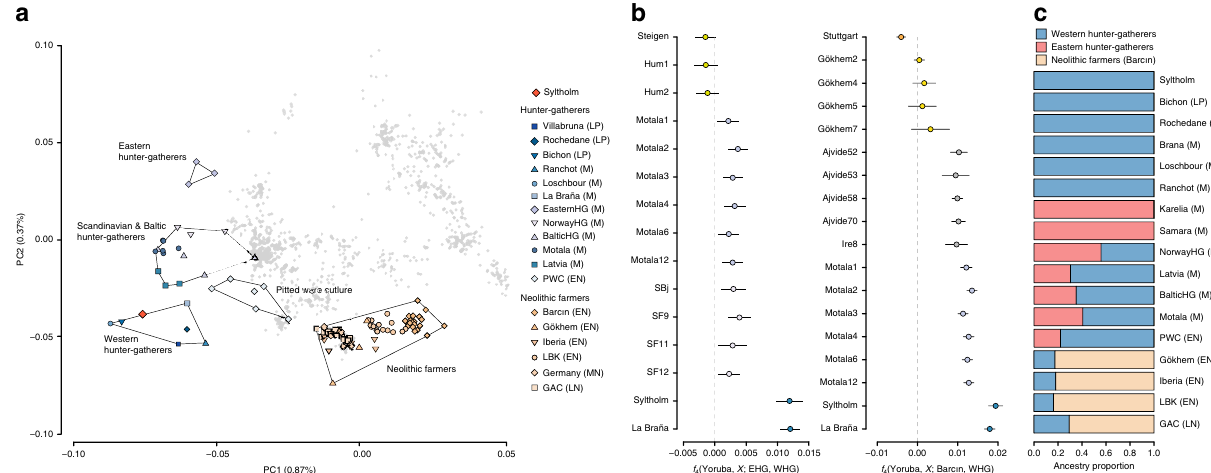
Fig. 2 Genetic af fi nities of the Syltholm individual. a Principal component analysis of modern Eurasian individuals (in grey) and a selection of over 100 previously published ancient genomes, including the Syltholm genome. The ancient individuals were projected on the modern variation (see Methods). b Allele-sharing estimates between the Syltholm individual, other Mesolithic and Neolithic individuals, and WHGs versus EHGs and Neolithic farmers, respectively, as measured by the statistic f 4 (Yoruba, X ; EHG/Barc ı n, WHG). c Ancestry proportions based on qpAdm 12 , specifying WHG, EHG, and Neolithic farmers (Barc ı n) as potential ancestral source populations. PWC Pitted Ware Culture, LBK Linearbandkeramik, GAC Globular Amphora Culture, LP Late Paleolithic, M Mesolithic, EN Early Neolithic, MN Middle Neolithic, LN Late Neolithic. Data are shown in Supplementary Tables 4 –